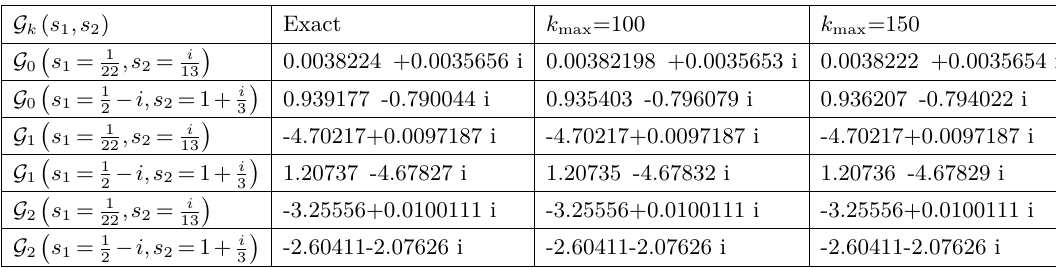
Table 4 . Verification of the dispersion integral (2.8) against Lovelace-Shapiro model. We put Disc G ( s ) from (A.5), (A.6), (A.7) in formula (2.8). For numerical purpose, we truncate the k 1 , s 2 k -sum upto say k max